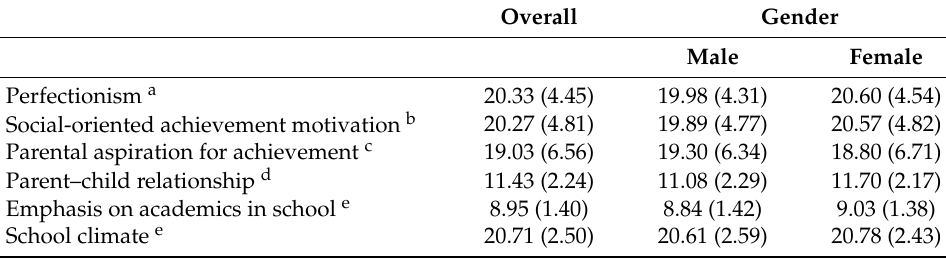
Overall Gender Male Female